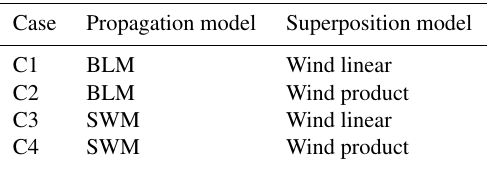
Table 3. Simulations performed with the two wake propagation models and two wake superposition models in